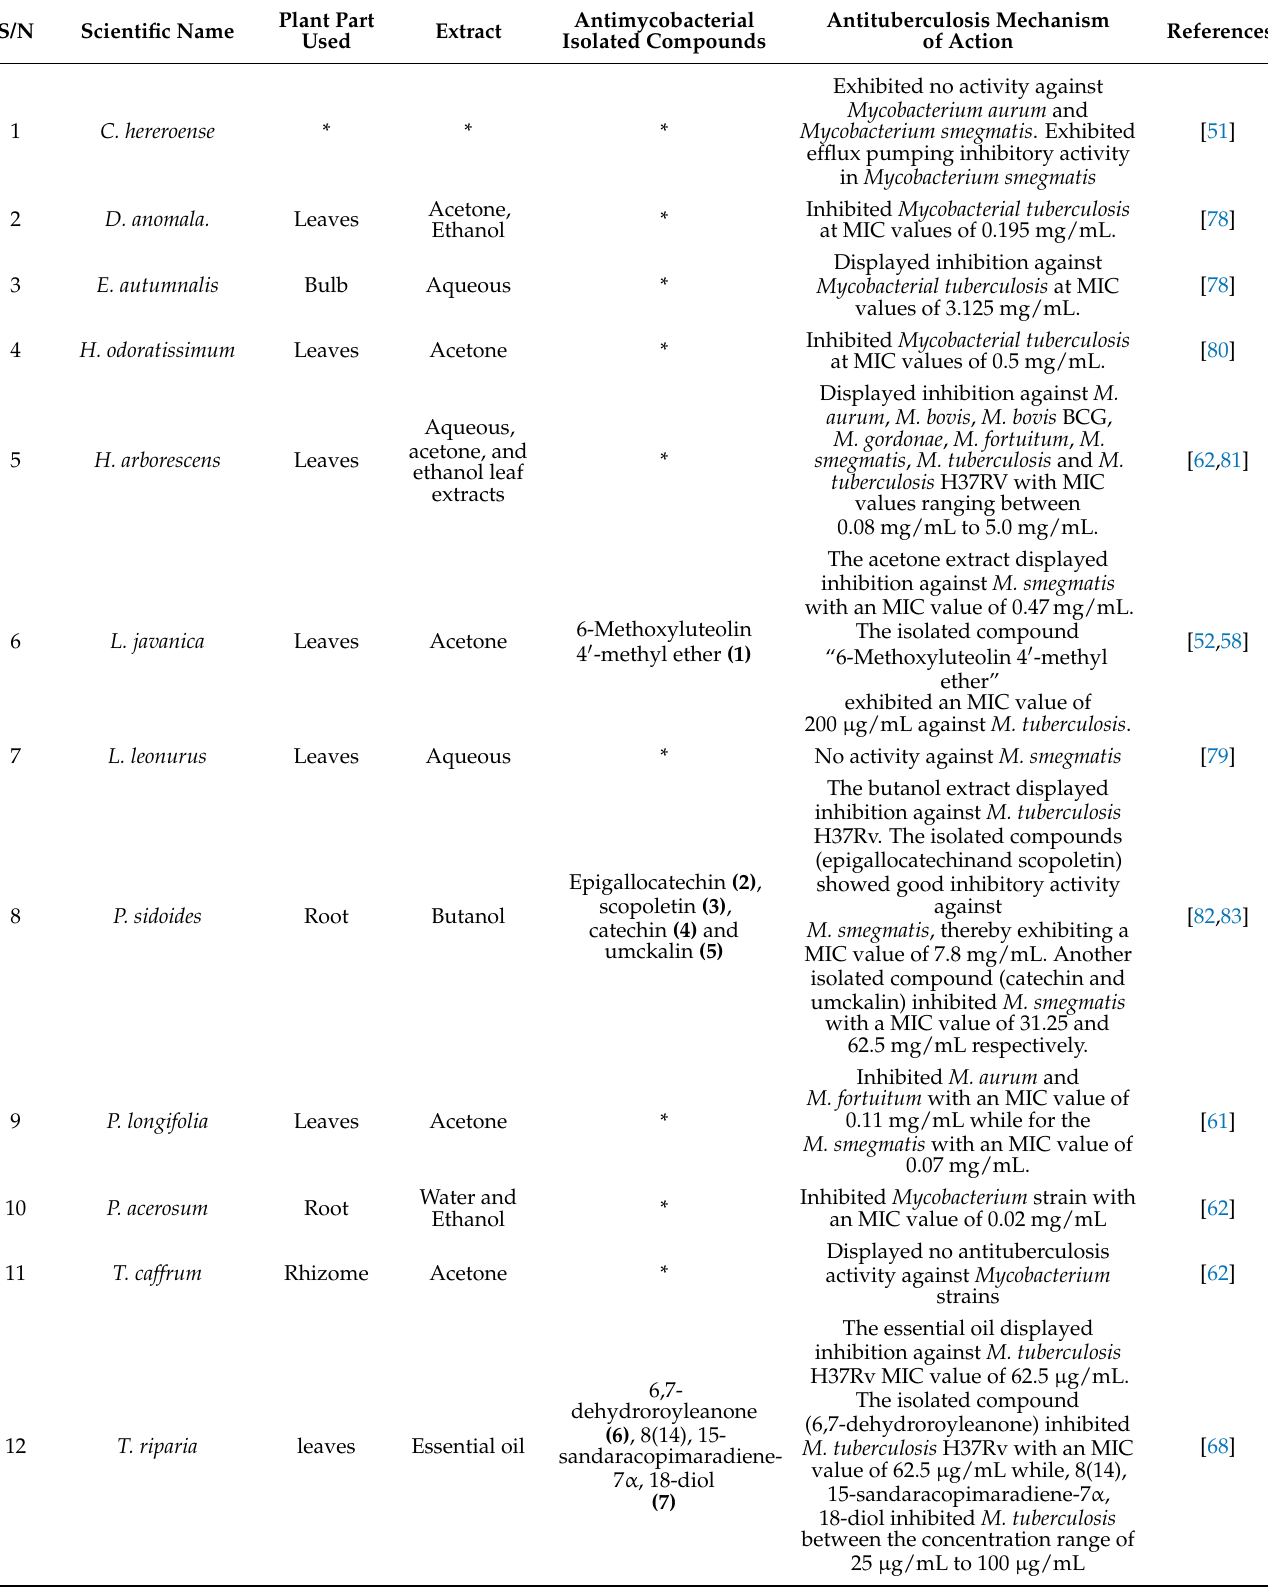
Table 3. Reported antituberculosis activity of medicinal plants used in the Mpumalanga